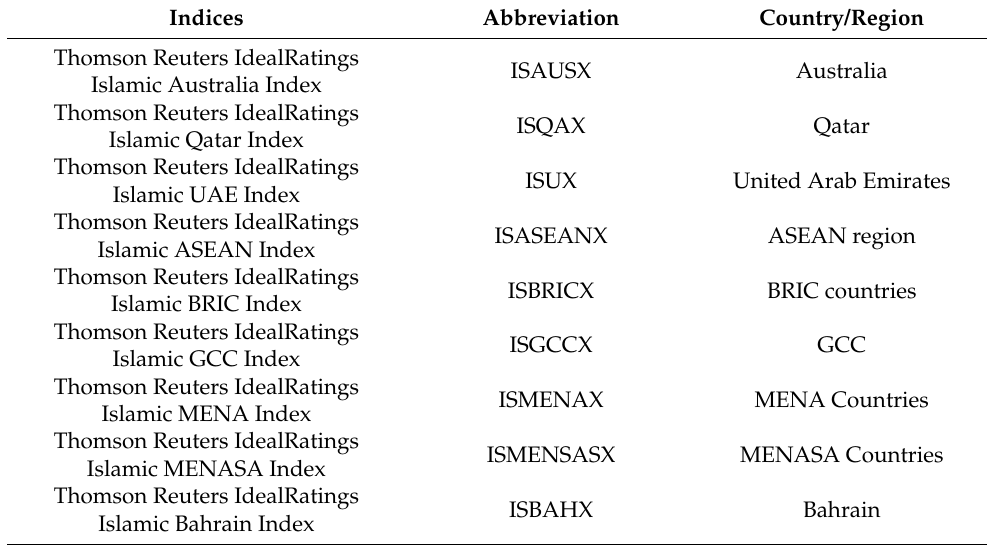
Table 1. Selected Islamic